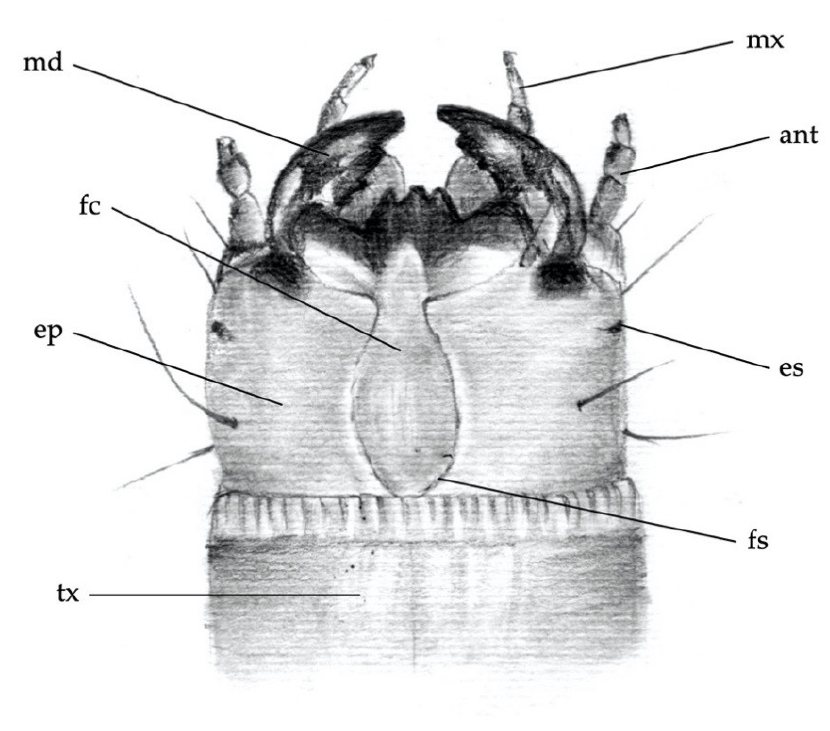
Figure 1. Anatomy of the larva. Dorsal head capsule and 1st thoracic segment: ant, antenna; ep, epicraneal plate; es, stemma; fc, frontoclypeus; fs, frontal suture; md, mandible; mx, maxillary palp; tx, prothorax.